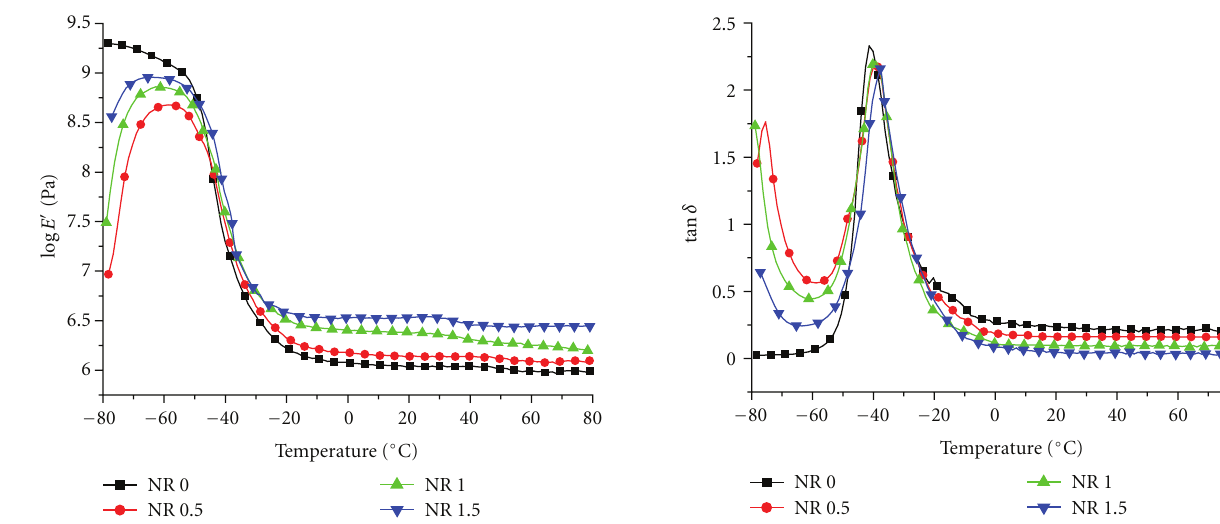
Figure 5: Dependences of mechanical loss angle tangent on tem- perature and filler